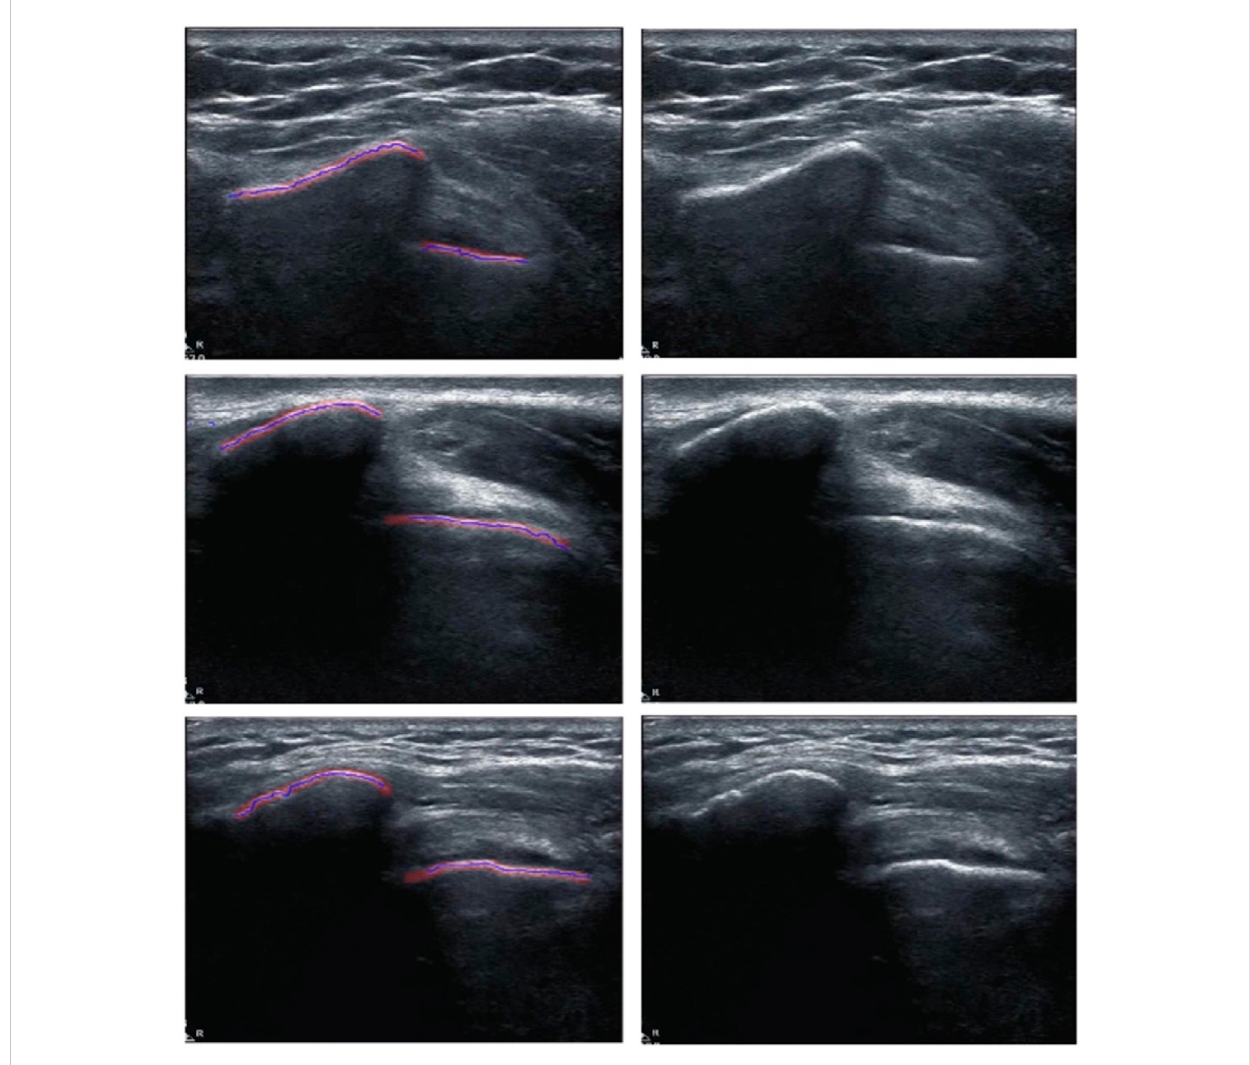
FIGURE 3 Acromion and humeral head surfaces determined by CAQUSA and manual measurement. Pictures in 1 st column show bone surface detected by CAQUSA (blue) and manual section (red). Pictures in 2 nd column are original